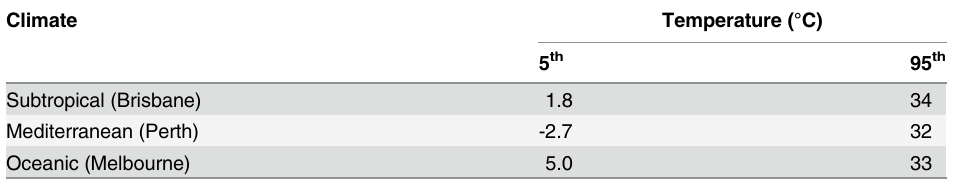
Table 5. Estimated temperature percentile values in different